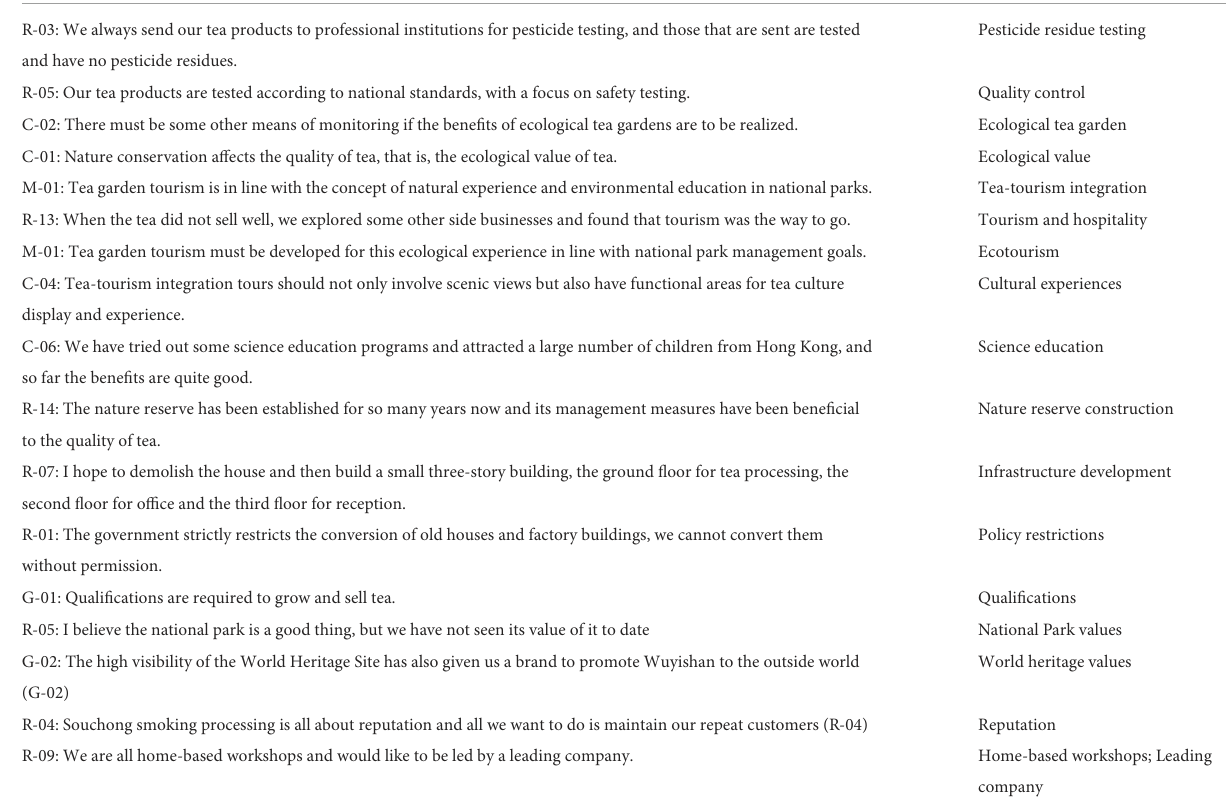
TABLE 1 Some representative results from open